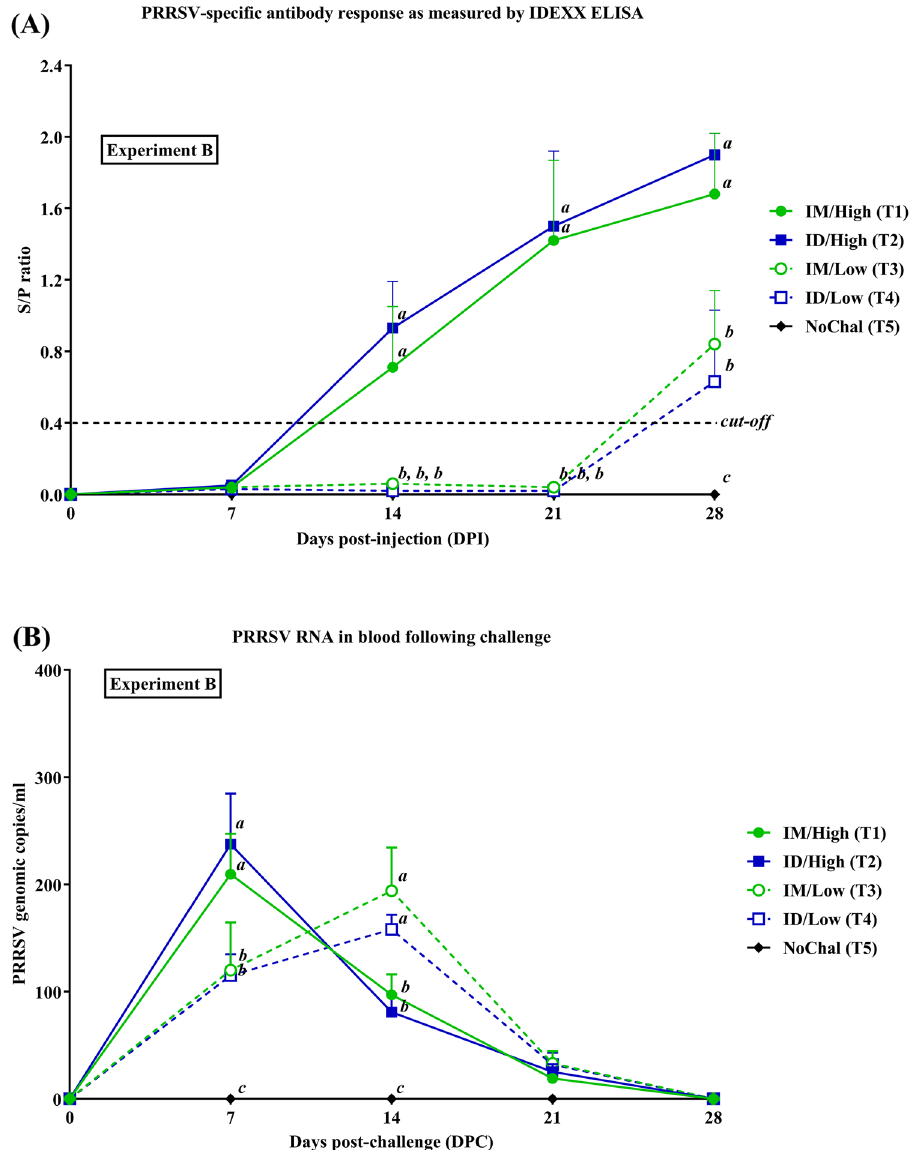
Figure 6. Mean values of ( A ) PRRSV-specific antibodies as measured by ELISA and ( B ) genomic copies of PRRSV RNA in the blood of pigs in Exp B. Values expressed as mean ± SEM. ( A ) Sample-to-positive (S/P) ratios equal to or greater than 0.4 was considered positive (cut-off value, dashed-line). The results were compared using two-way ANOVA for multiple comparisons. Different lowercase letters ( a – c ) indicate significant differences between treatment groups ( P < 0.05) for each